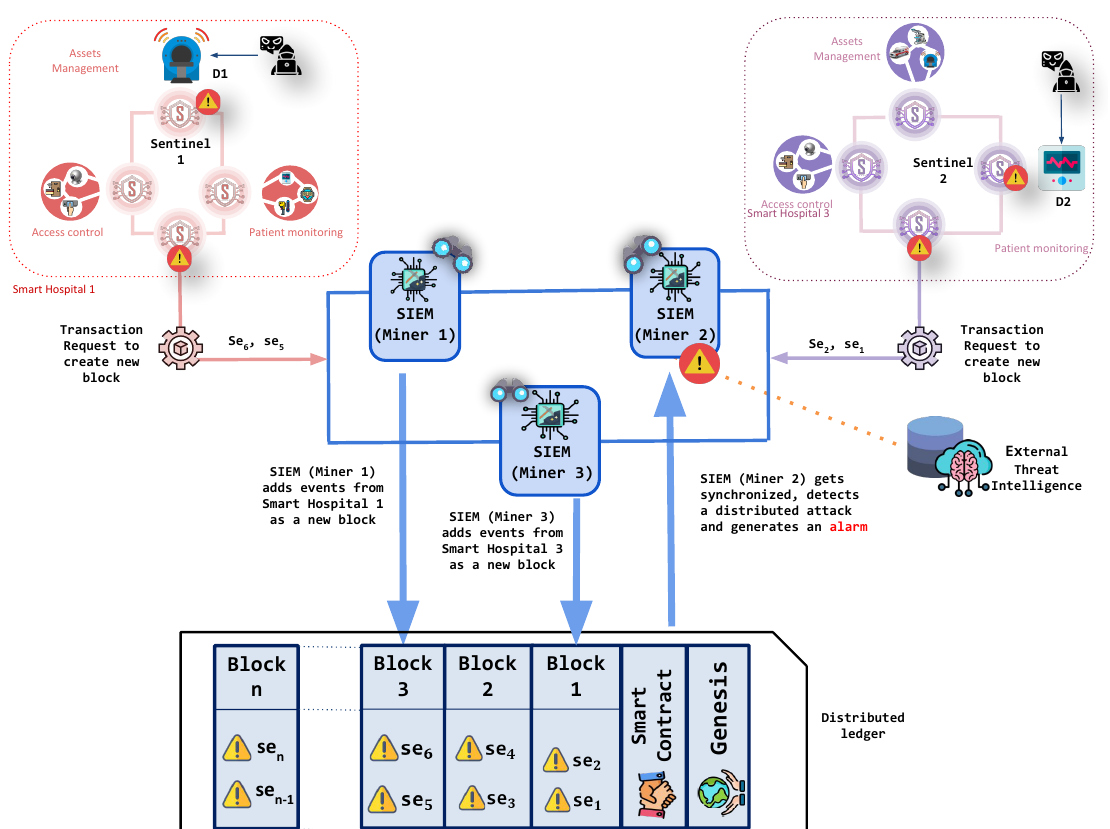
Figure 2. Detection of a distributed attack from security events coming from different